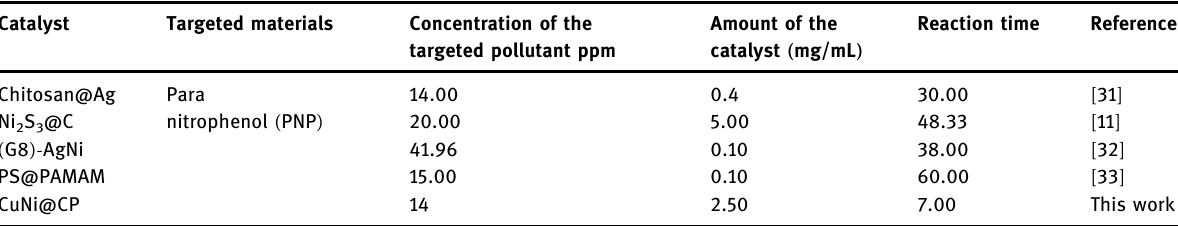
Table 1: Comparison of the data with the literature for the reduction of PNP Catalyst